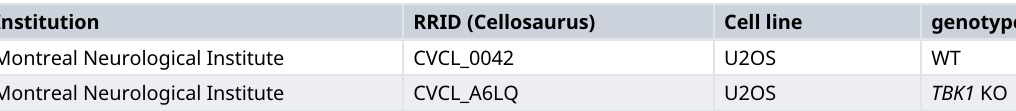
Table 1. Summary of the cell lines